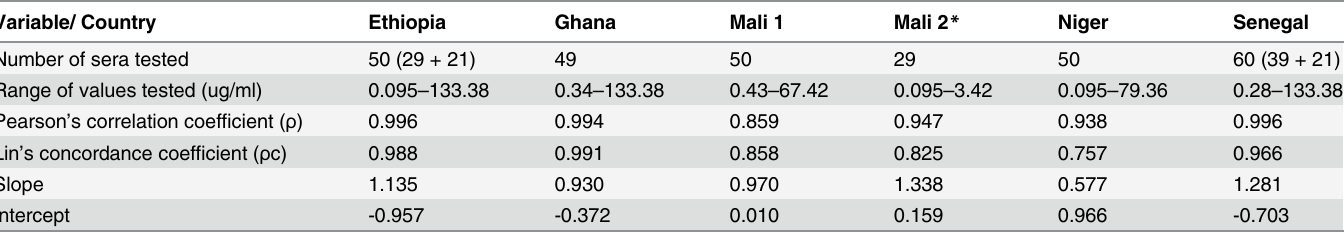
Table 1. Statistical analysis of a comparison of meningococcal serogroup A IgG concentrations obtained at the Vaccine Evaluation Unit (VEU), Public Health England and at five MenAfriCar centres. Variable/ Country Range of values tested